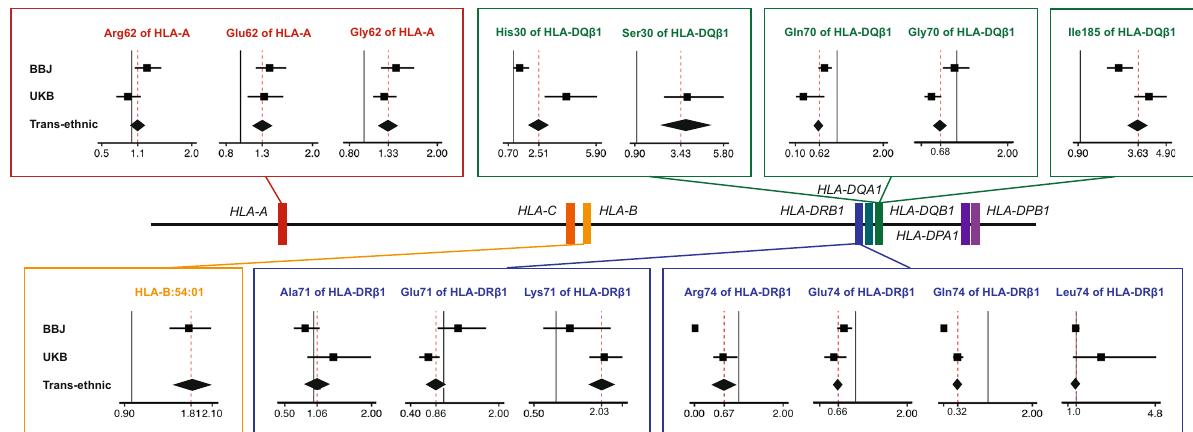
Fig. 6 HLA variants associated with the T1D risk identi fi ed through trans-ethnic fi ne-mapping. Forest plots for individual risk-associated alleles are displayed along with a location map of classical HLA genes. Each forest plot shows the estimated odds ratio (OR) and 95% con fi dence interval from cohort-speci fi c logistic model for BBJ and UKB, and the transethnic logistic model. Red dashed lines indicate OR in transethnic cohorts. Black solid lines represent OR = 1. Colored square boxes represent amino acid polymorphisms of the same position or a classical allele. Source data are provided as a Source Data fi le. BBJ BioBank Japan, UKB UK Biobank.